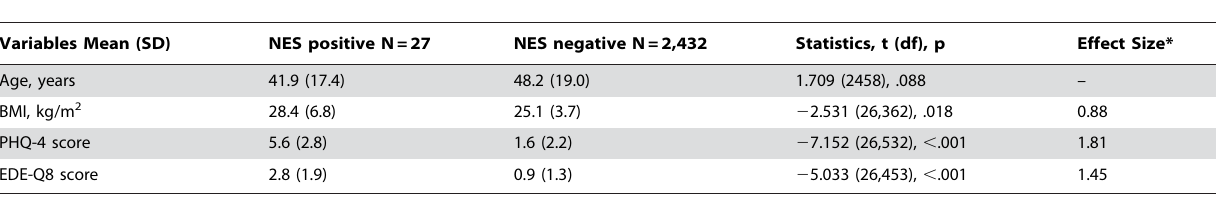
Table 1. Comparison between participants with and without a positive screening result for NES (weighted sample).